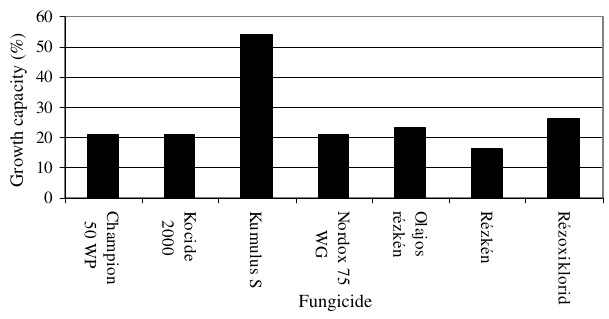
Figure 1. Percent growth capacity of Monilinia laxa for 7 fungicides (organically approved) admended on PDA plates at 1 × dosage recommended by the manufacturer (LSD